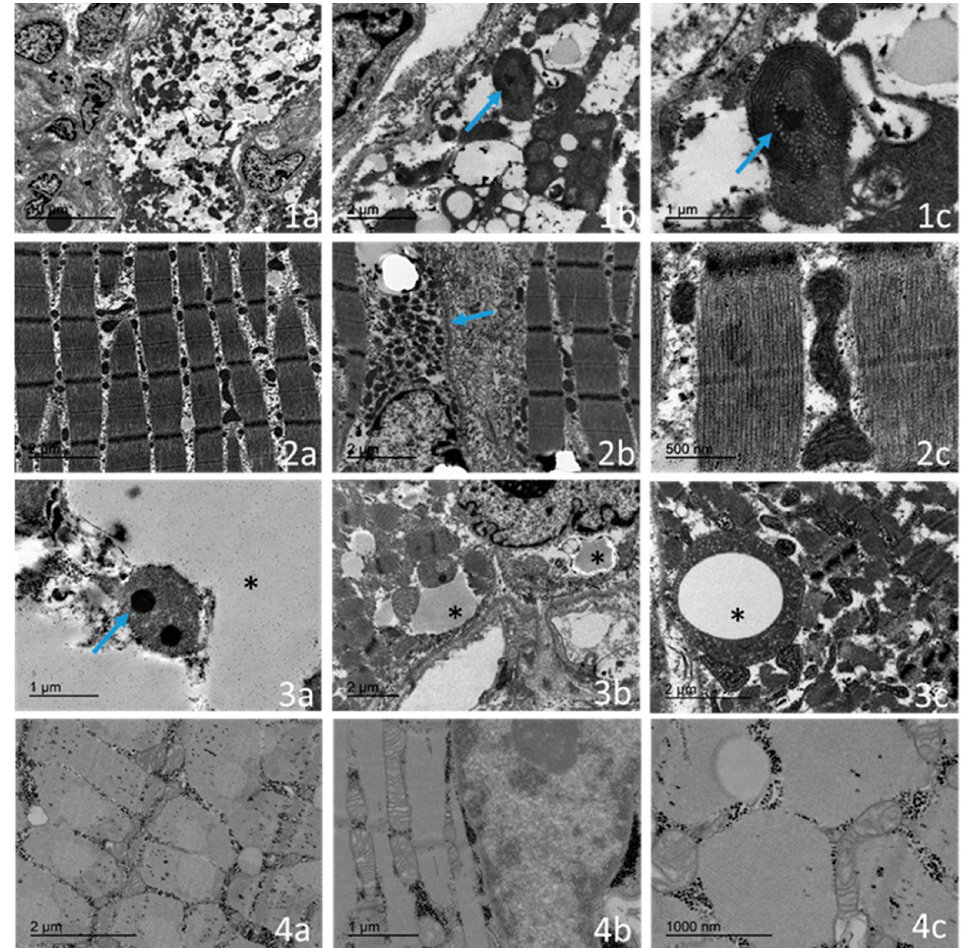
Figure 4. Transmission electron micrograph of the infantile-onset form (case 1) in the skeletal muscle region, showing a marked distortion of the intermyofibrillary pattern with an increase in the number of mitochondria and content of lipids ( 1a : scale bar of 10 µm was chosen to better observe a single muscular fibre). The mitochondria are enlarged with abnormal cristae (blue arrow) ( 1b : scale bar of 2 µm) and concentric, “onion-shaped” cristae with electrodense granule (blue arrow) ( 1c : scale bar of 1 µm was chosen to detect the electrodense inclusions that are not appreciable with lower magnification). The childhood-onset form (case 7) shows a relative conserved sarcomeric structure with a mild increased lipid content and lipid droplet size ( 2a : scale bar of 2 µm). Mitochondria are arranged around the nucleus with a slight increase in quantity (blue arrow) ( 2b : scale bar of 2 µm). The isolated mitochondria show mild abnormalities ( 2c : scale bar of 0.5 µm was chosen to rule out the presence of electrodense inclusions and intramitochondrial vacuoles). In the other infantile-onset patient (case 4), we observed intramitochondrial electrodense inclusions (blue arrow) ( 3a : scale bar of 1 µm); there is an intimate relationship between the mitochondria and lipid droplets (star) ( 3b : scale bar of 2 µm), and the intramitochondrial vacuoles contain fine granular material (star) ( 3c : scale bar on 2 µm). The healthy control child showed normal-sized mitochondria with unaltered cristae networks ( 4a : scale bar of 2 µm; 4b : scale bar of 1 µm; 4c : scale bar of 1 µm). Electrodense inclusions are not appreciable at a 1 µm scale bar.